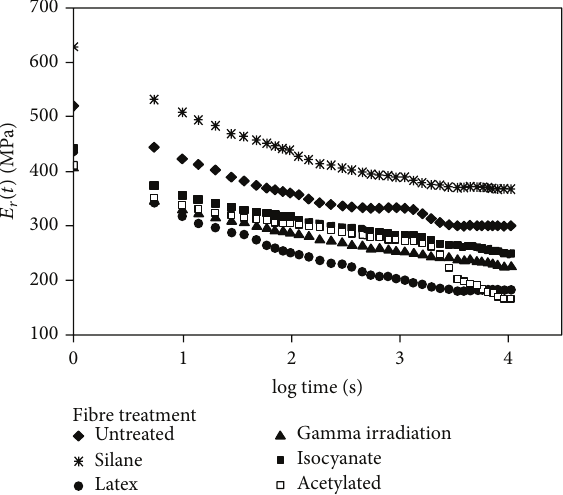
Figure 5: Relaxation modulus curves of untreated and treated OPEFB fiber at 10% strain